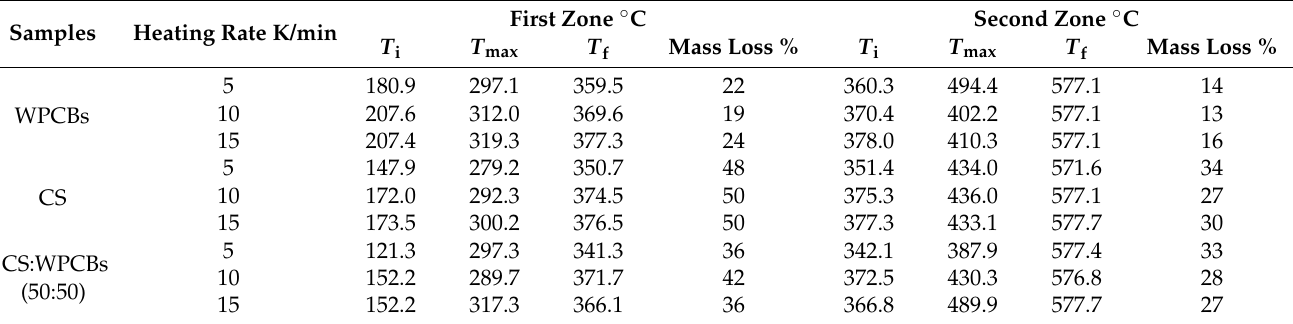
Table 4. Mass loss (in %) for first and second zone.